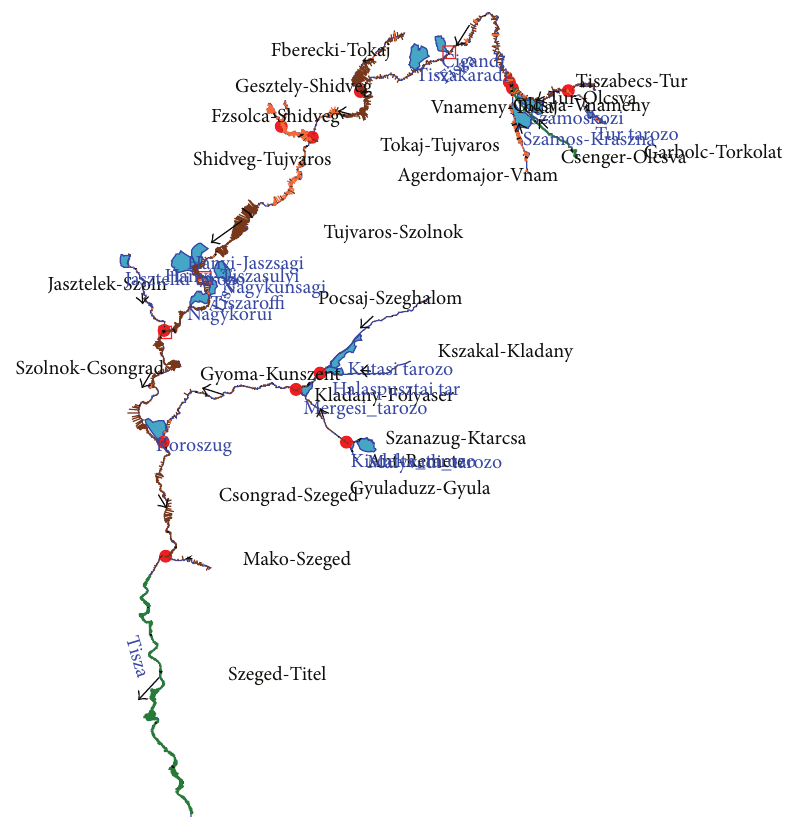
Figure 1: Stream network of the Tisza